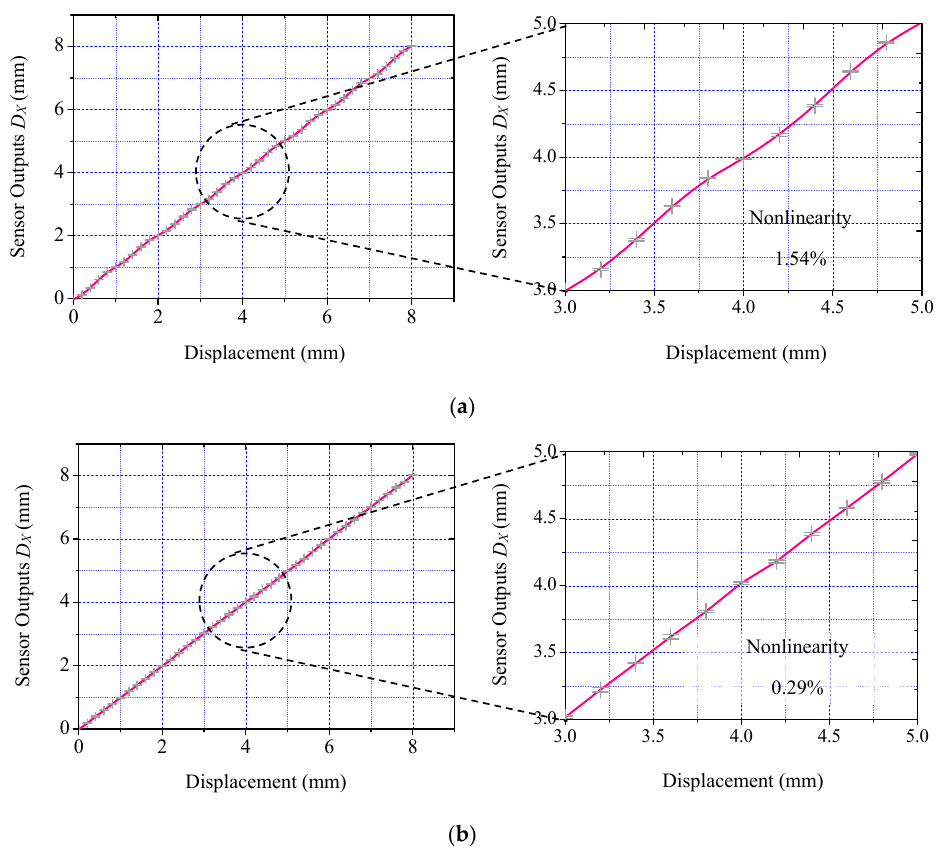
Figure 8. Acquired nominal displacement in X direction: ( a ) the conventional scheme; ( b ) the proposed